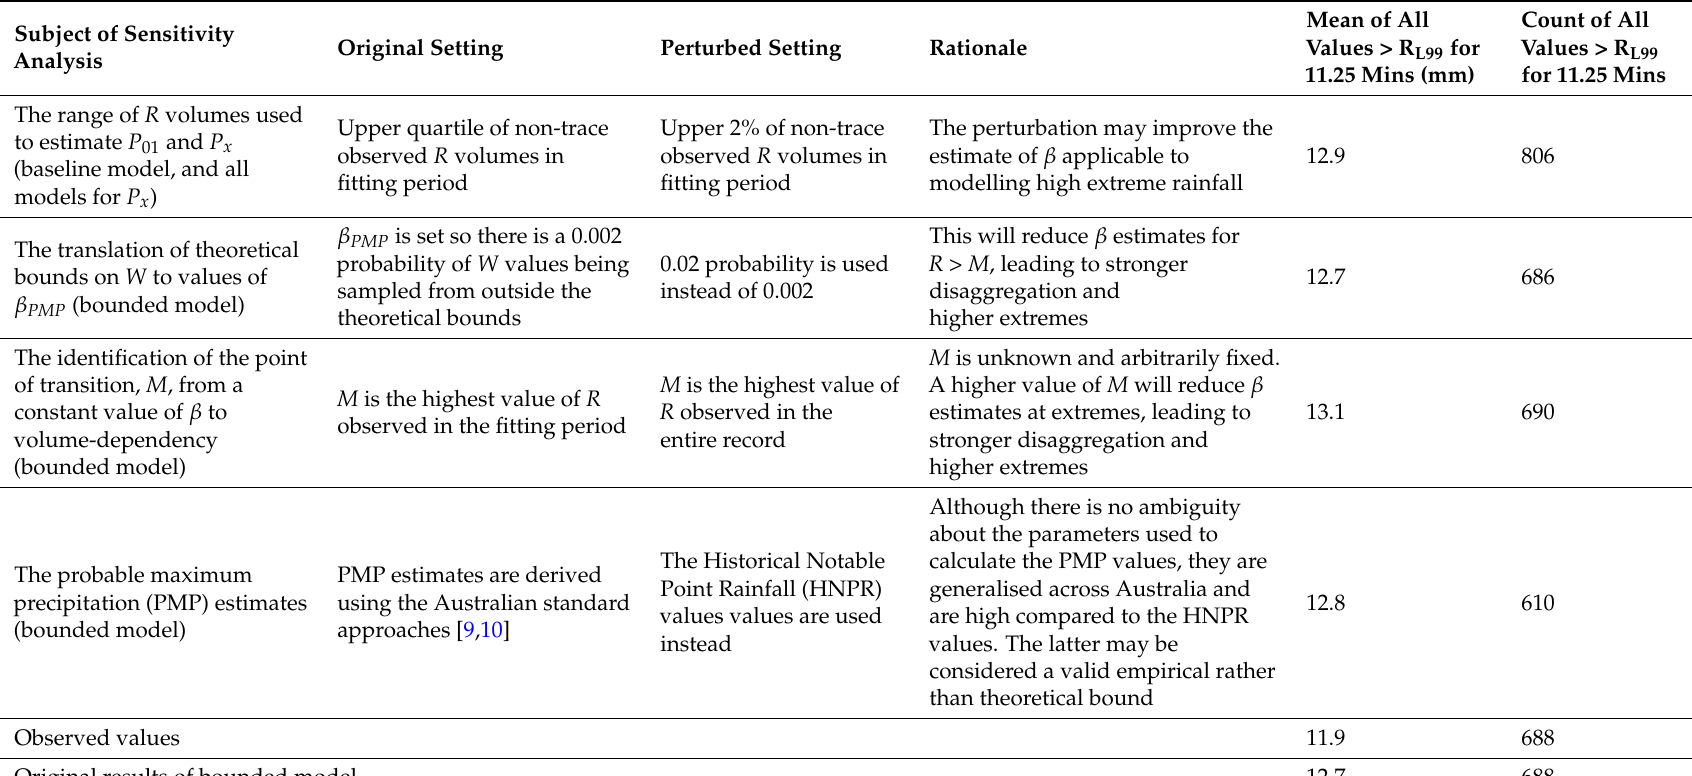
Table 2. Sensitivity analyses